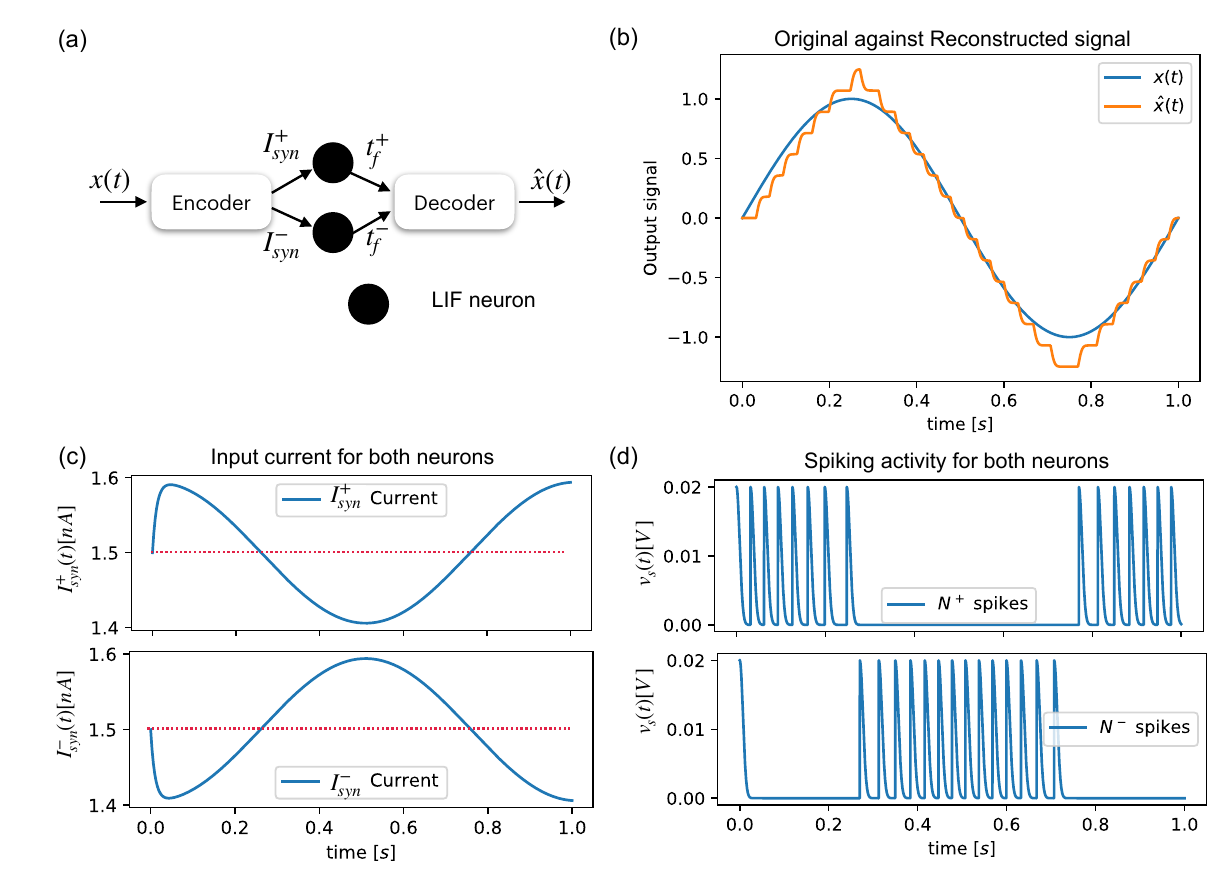
Figure 3. Signal reconstruction using neurons and encoding/decoding algorithms. ( a ) Assembly of the encoding/decoding, which alternate the input currents of two different neurons. ( b ) Comparison between the original signal x ( t ) and reconstructed signal ˆ x ( t ) . ( c ) Spiking activity response for each neuron. ( d ) Input currents I + syn , I − syn for the neurons (Blue) versus the riobase (red dotted). ( d ) Output spikes for each neuron in the assembly.